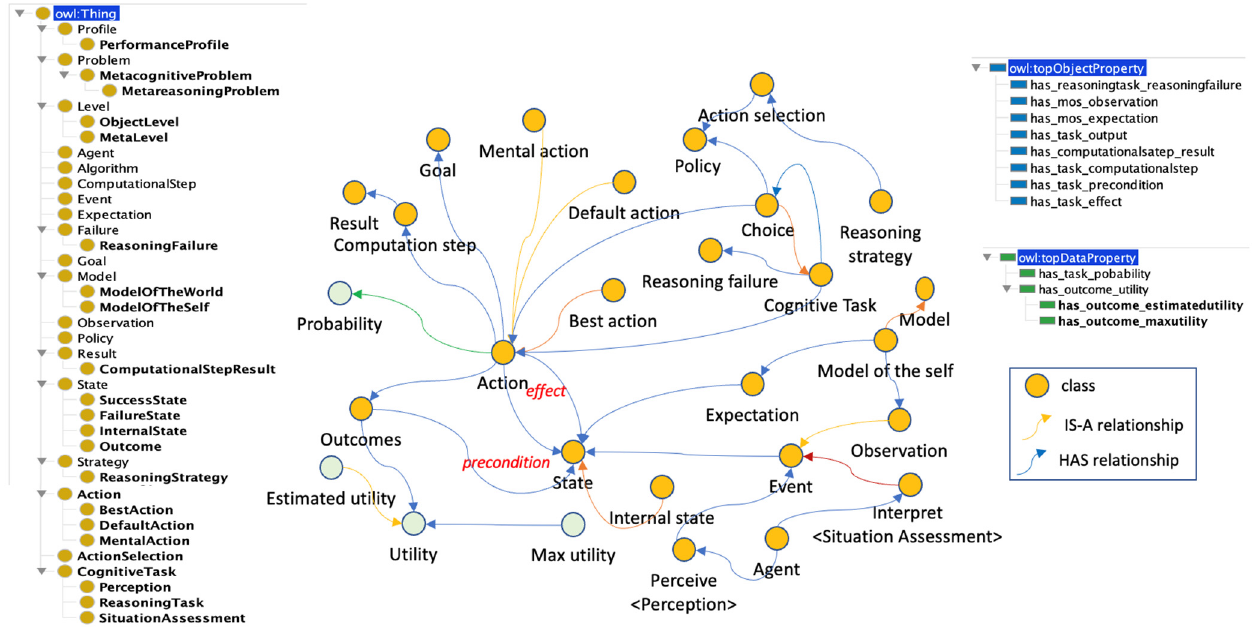
Figure 10. The GCPDP subontology.